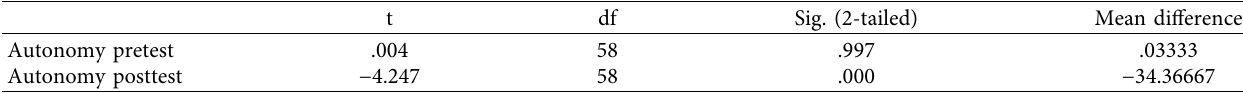
Table 4: Independent-sample test:a T -test for equality of means.